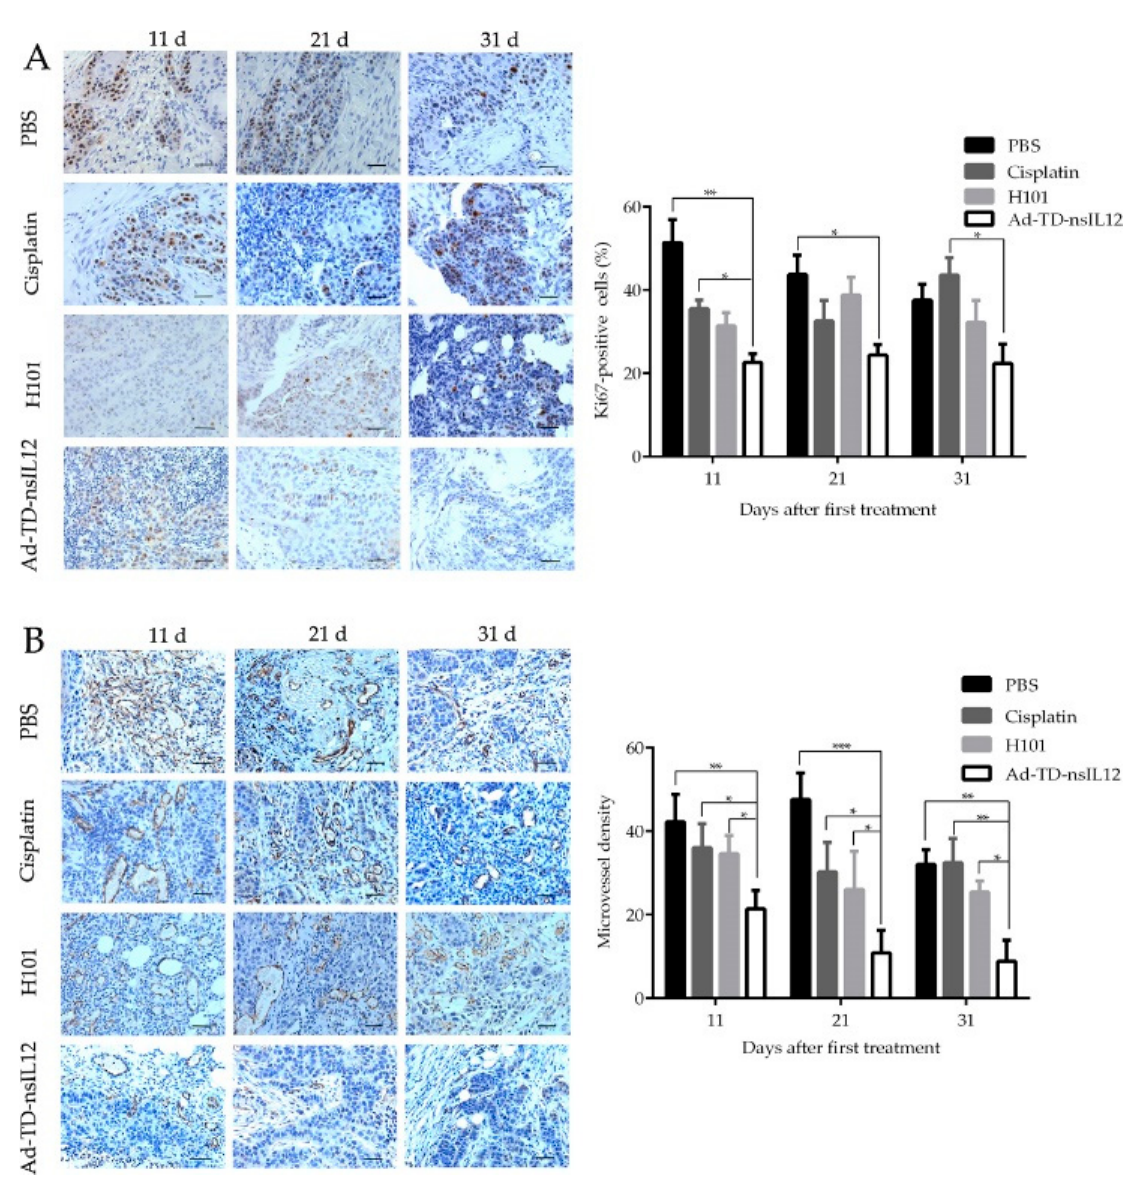
Figure 6. Ad-TD-nsIL12 can inhibit the proliferation activity of tumor cells and reduce the microvessel density of tumor tissue. ( A ) Ki67 staining of tumor cells in xenografts. The percentage of Ki67 positive cells was determined in five high-power fields of tumor section; ( B ) CD31 staining of xenografts in each group. The mean microvascular density was determined by counting CD31-positive microvascular structures in five high-power fields of tumor section. The data are calculated as mean ± SD and analyzed by one way ANOVA. Scale bar: 50 µm. * p < 0.05, ** p < 0.01, *** p < 0.001.